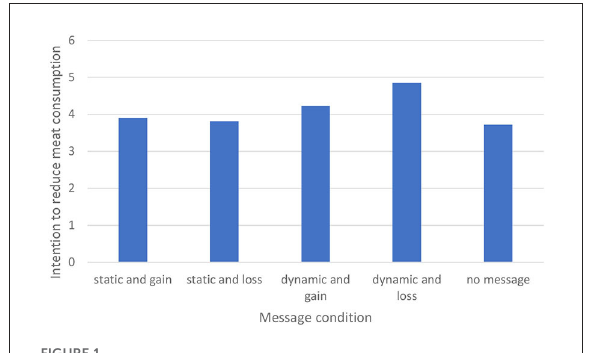
FIGURE1 Means for each of the five experimental groups on the intention to reduce meat consumption.